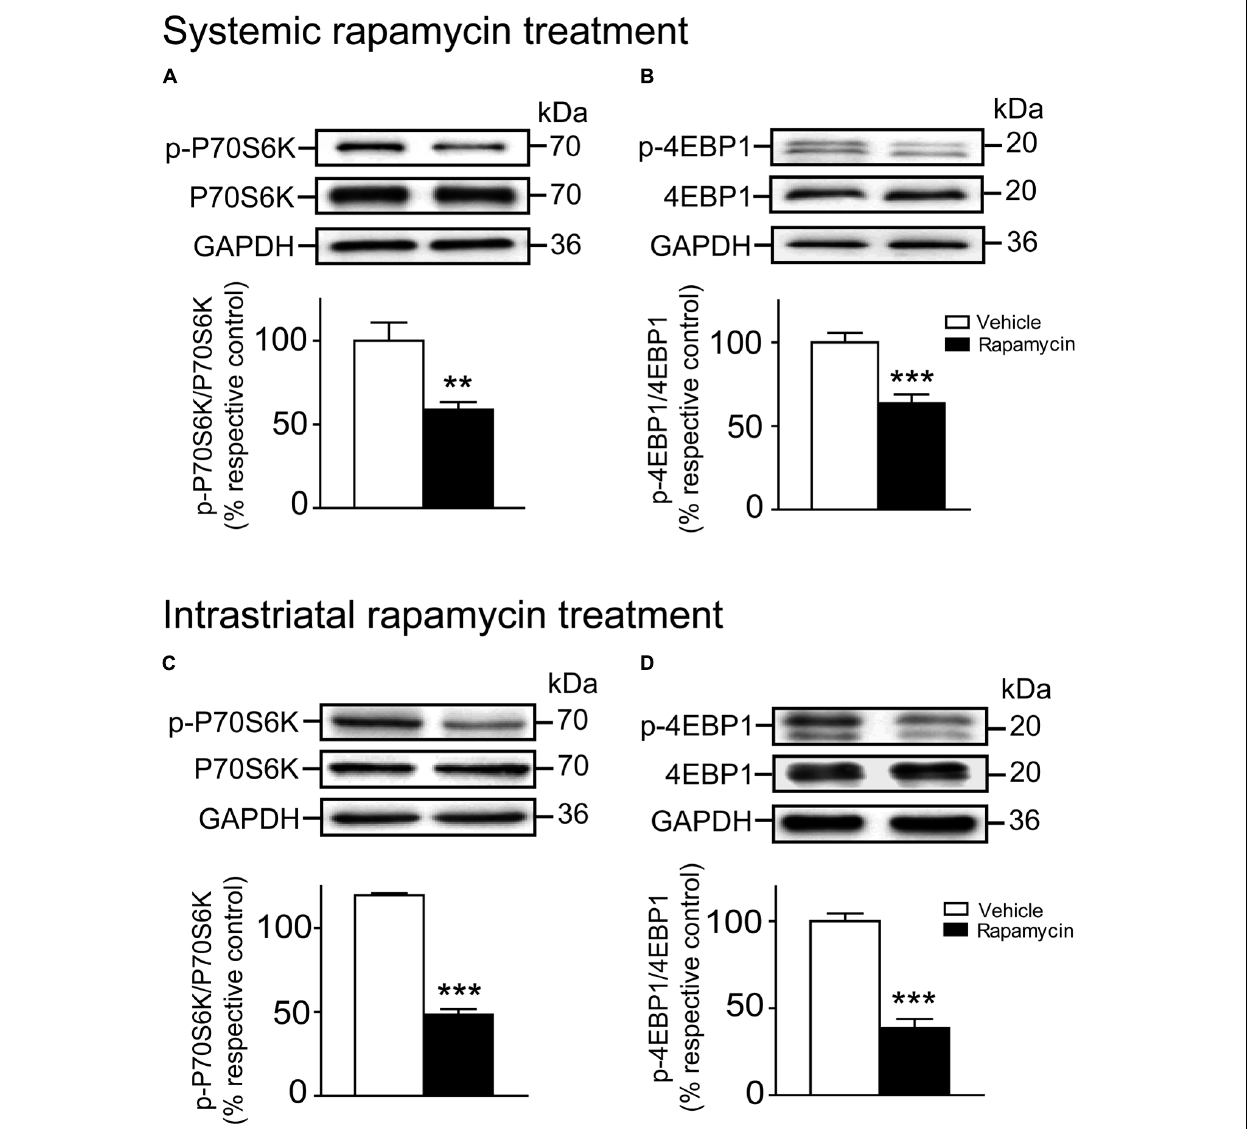
FIGURE 5 | Systemic and intrastriatal rapamycin treatments decreased the phosphorylation levels of striatal mTORC1 downstream substrates. Levels of total and phosphorylated (A) P70S6K and (B) 4EBP1 were evaluated by western blot after systemic rapamycin treatments. The data, expressed to relative total P70S6K or 4EBP1 levels, represent the mean of relative optical density of phosphorylated P70S6K or 4EBP1 (expressed as a percentage of control values) ± S.E.M, n = 8–12 vehicle (DMSO) and rapamycin-treated mice; triplicate experiments for each mouse/group.